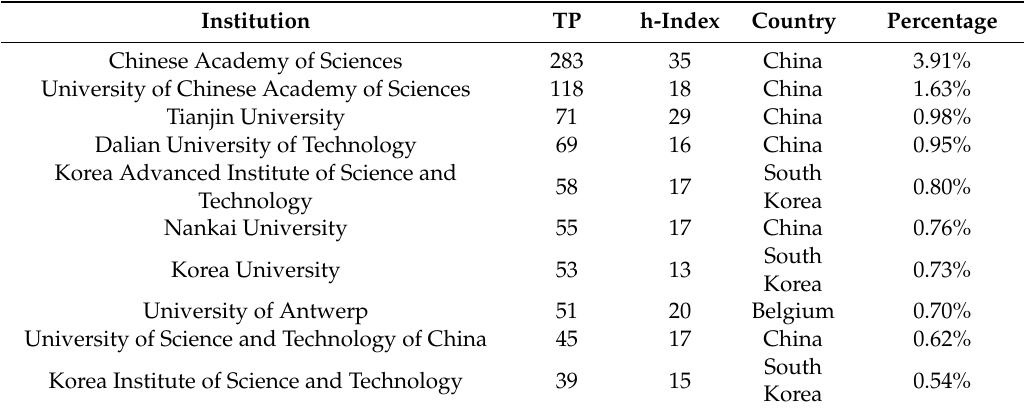
Table 2. Top ten institutions with a large number of documents (TP > 39).